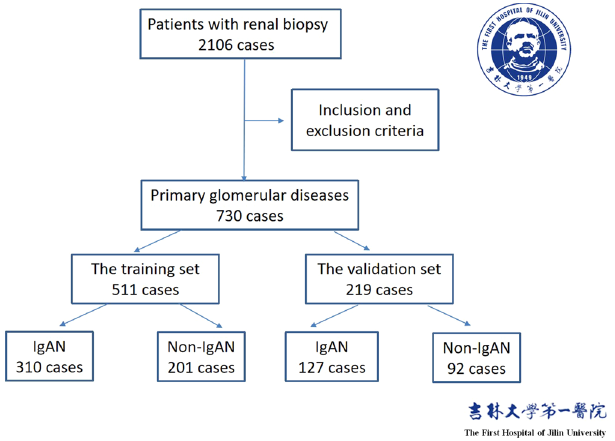
Figure 1. The flow diagram of subjects screening and grouping.